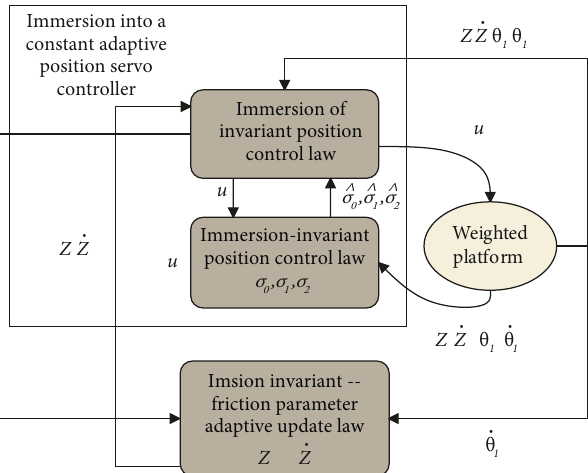
Figure 2: Block diagram of design of immersion invariant adaptive disturbance compensation control law.